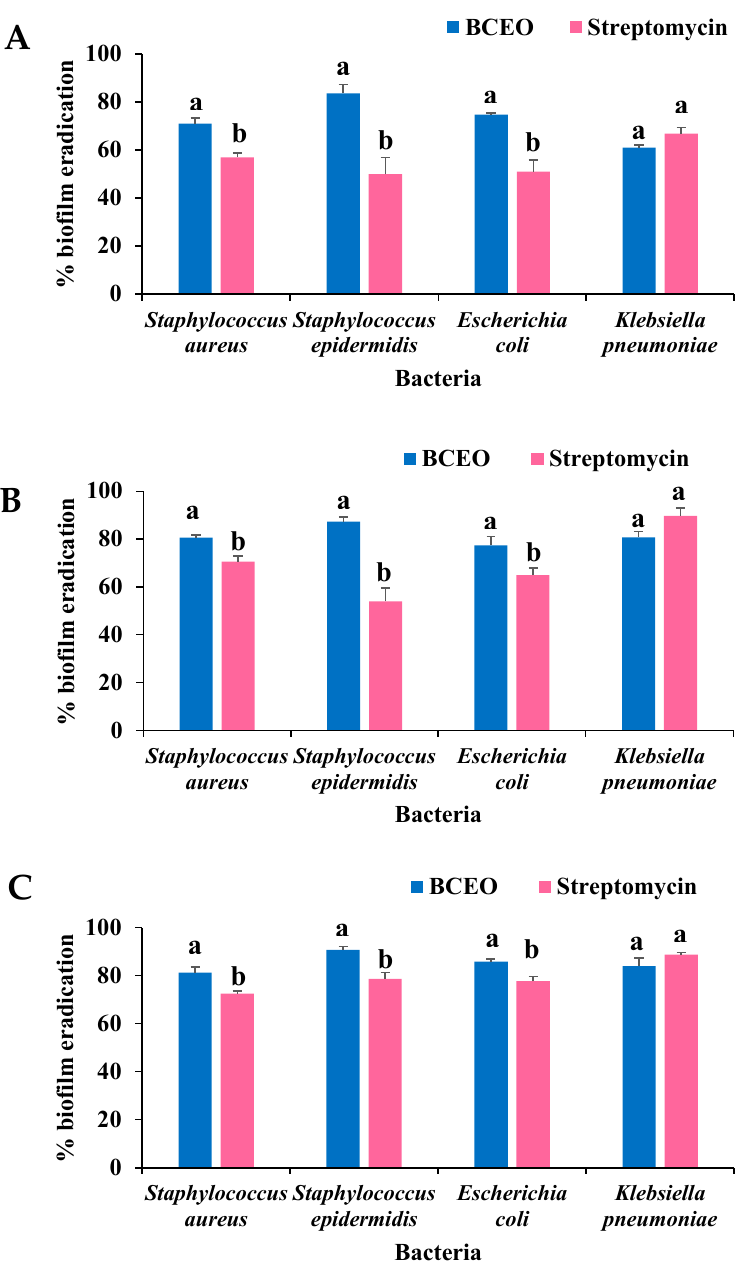
Figure 3. Effects of BCEO and streptomycin on the eradication of pre-formed biofilms of S. aureus , S. epidermidis , E. coli , and K. pneumoniae , expressed as biofilm eradication (%) at ( A ) 0.5 × MIC, ( B ) 1.0 × MIC, and ( C ) 2.0 × MIC. Bars represent mean ± SD of triplicates in three independent experiments. Error bars are standard deviations. Within the same bacteria, bars with different letters (a, b) differ significantly ( p < 0.05). BCEO, B. citriodora essential